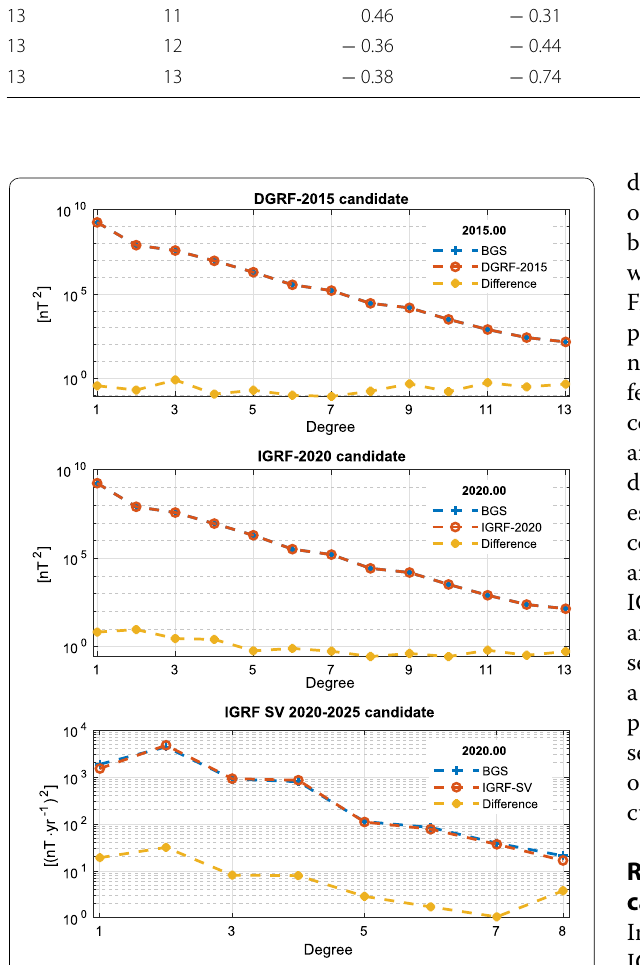
Fig. 4 Candidate spectra and spectra differences from final IGRF-13 models, chosen to be the median, median, and spatial Huber-weighted mean of the submitted candidates (top to bottom,